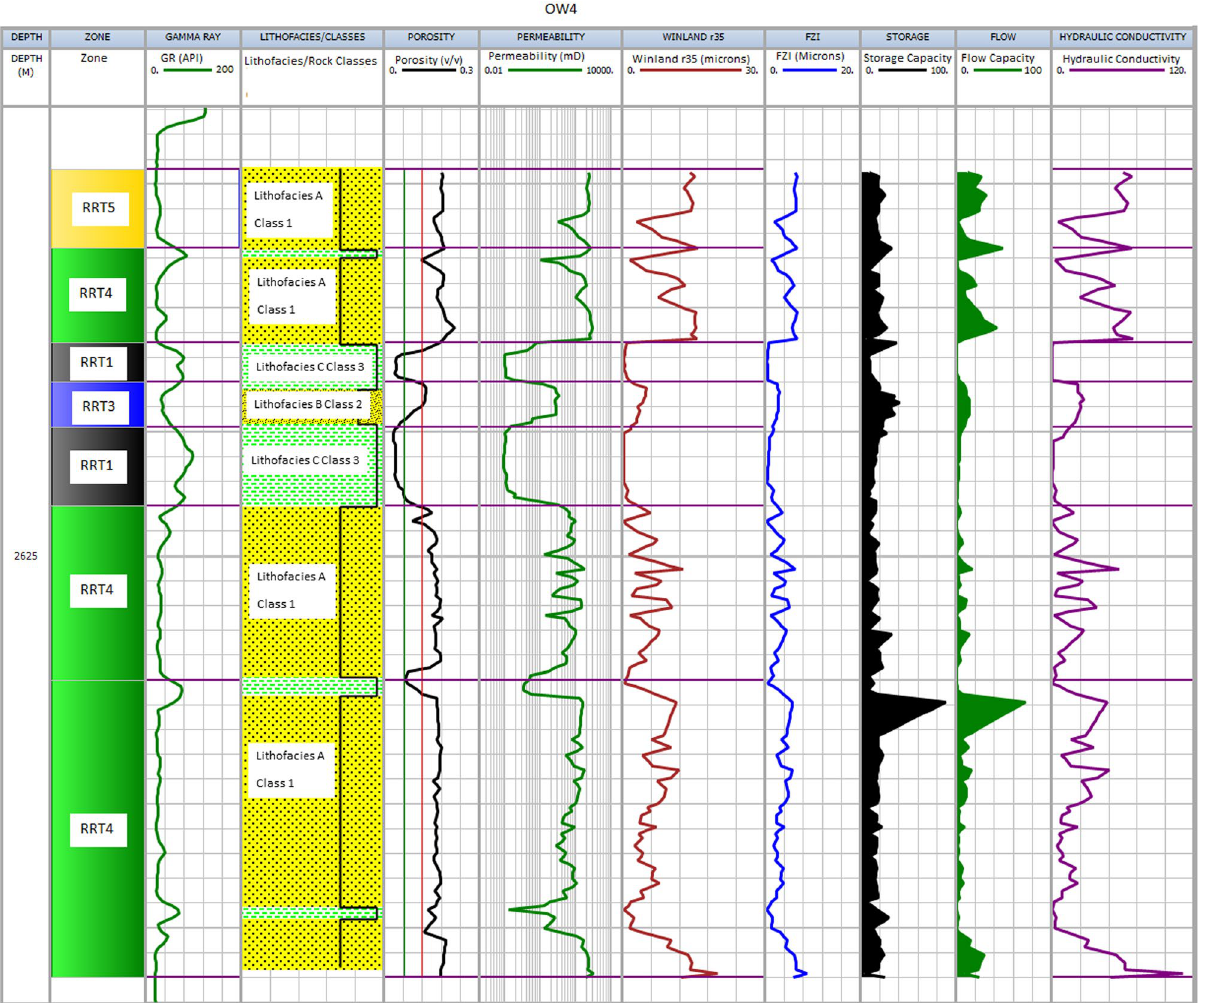
Figure 12. Shows the results for well OW4. Track 1 shows the measured depth. Displayed in tracks 2–9 are flow zones, Gamma ray log, lithofacies, porosity, permeability, Winand r35, Flow zone indicator, and hydraulic